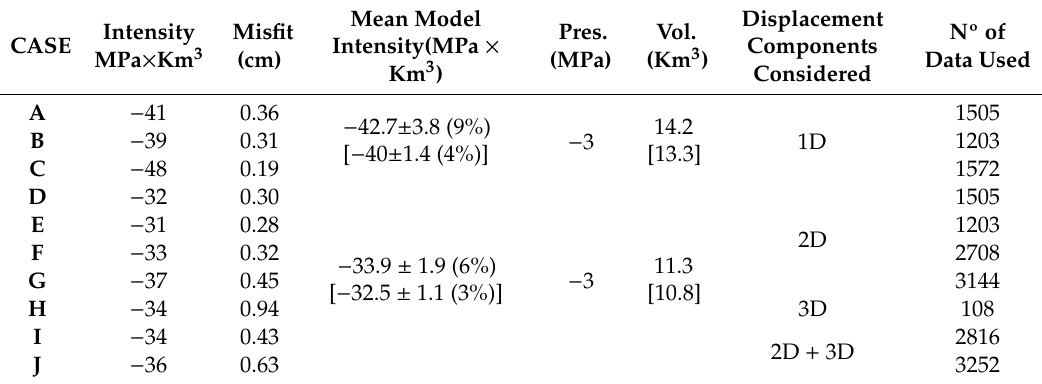
Table 3. Numerical summary of the inversion results for the ten cases considered 1